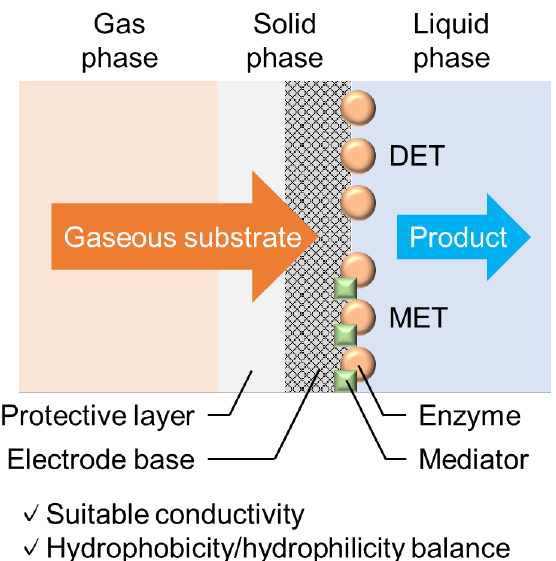
Figure 3. Schematic of a bio-three-phase interface of a gas-diffusion bioelectrode.